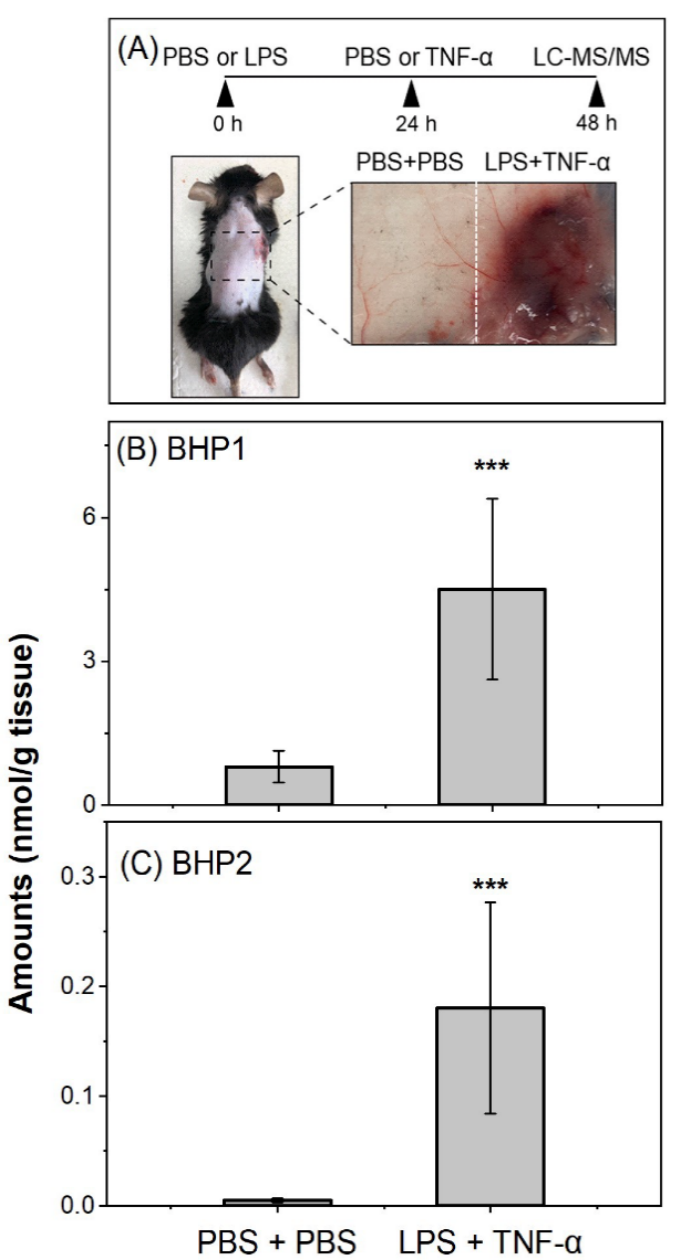
Figure 5. The formation of BHP1 and BHP2 in murine skin with inflammation and hemorrhage. ( A ) The mouse model was established by a dermal LPS injection followed by a TNF- α injection 24 h later to induce skin lesions with inflammation and hemorrhage. Two consecutive PBS injections were used as the control. For each mouse, the left dorsal skin was injected with PBS and the right one with LPS/TNF- α . Twenty-four hours after the TNF- α injections, skins were excised and subject to LC-MS/MS analyses after lysis by TRIzol TM reagent. ( B , C ) The BHP1 and BHP2 levels in the skins at the control (PBS + PBS) and the lesion sites (LPS + TNF- α ). The data were presented as means ± SD ( n = 9, *** p < 0.001; PBS, phosphate-buffered saline; LPS, lipopolysaccharide; TNF- α , tumor necrosis factor- α